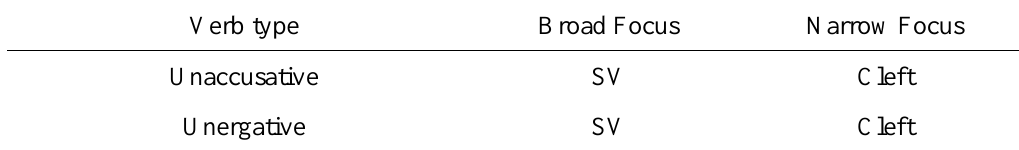
Table 2 . Expected word order of verb-type across focus-type in